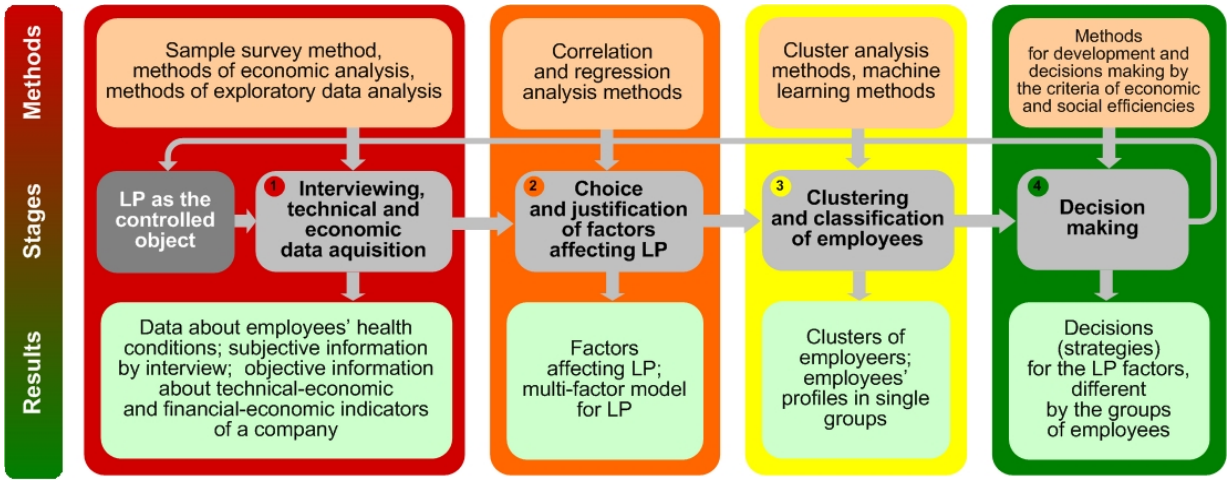
Figure 1. Conceptual scheme of technology for labor productivity (LP)